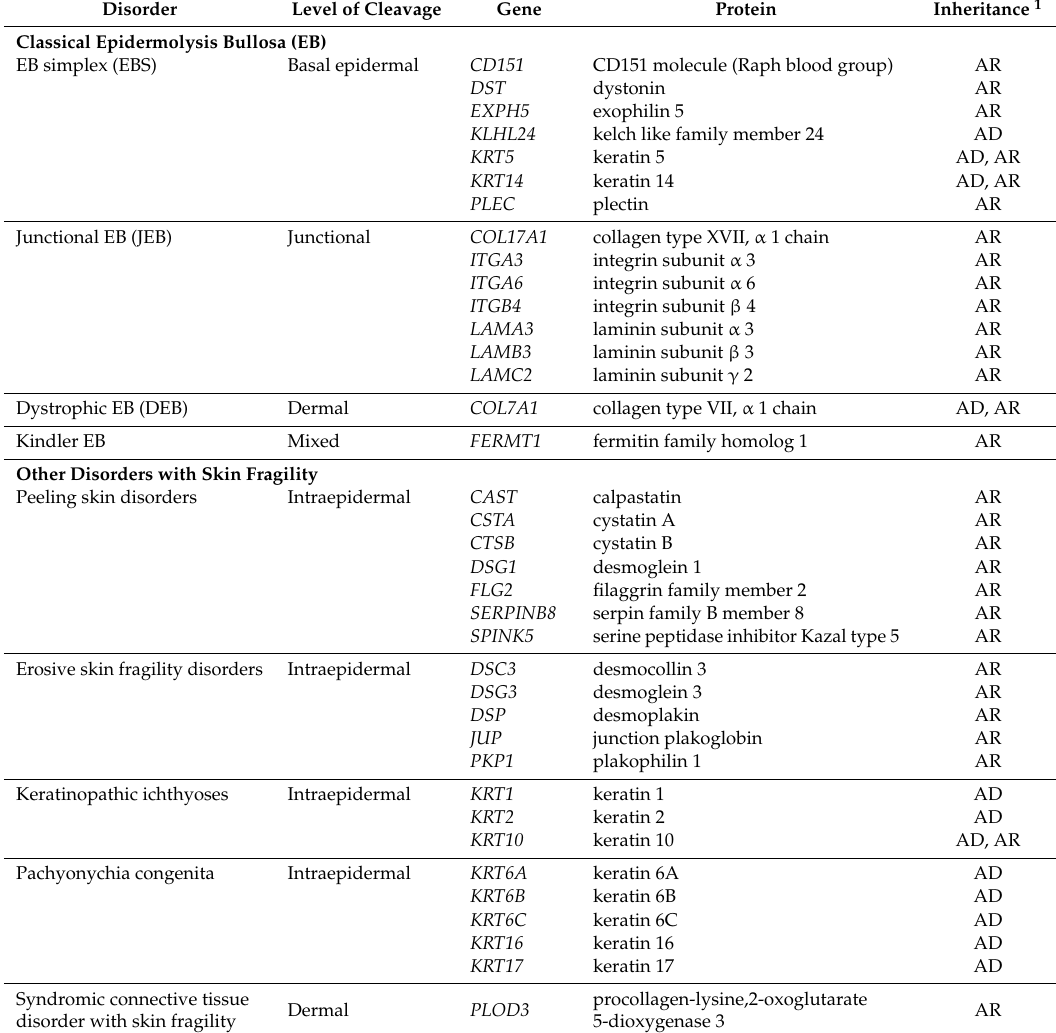
Table 1. Consensus reclassification of epidermolysis bullosa and other disorders with epidermal fragility and their known functional candidate genes, as of 2020